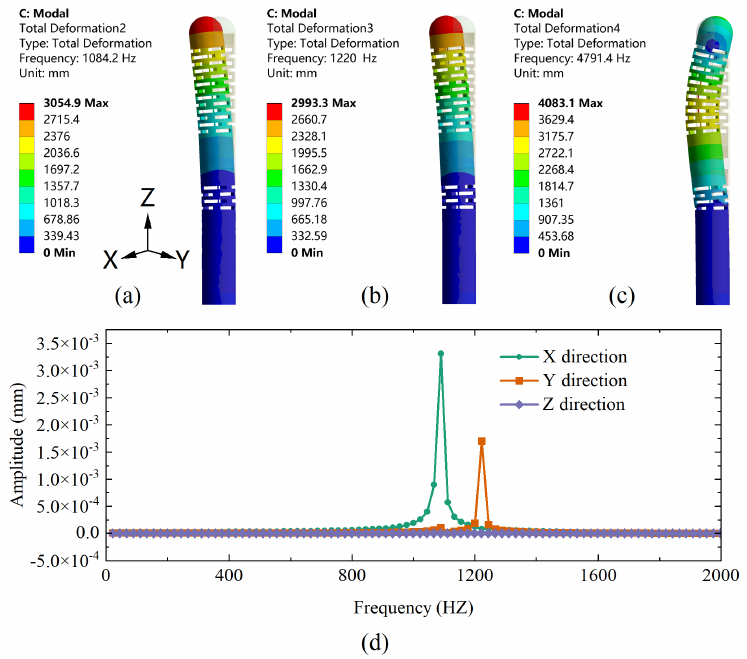
Figure 7. ( a ) First-order, ( b ) second-order, and ( c ) third-order modal analysis of the designed sensor. ( d ) The harmonic response curves of the designed sensor in X, Y, and Z directions under Fz